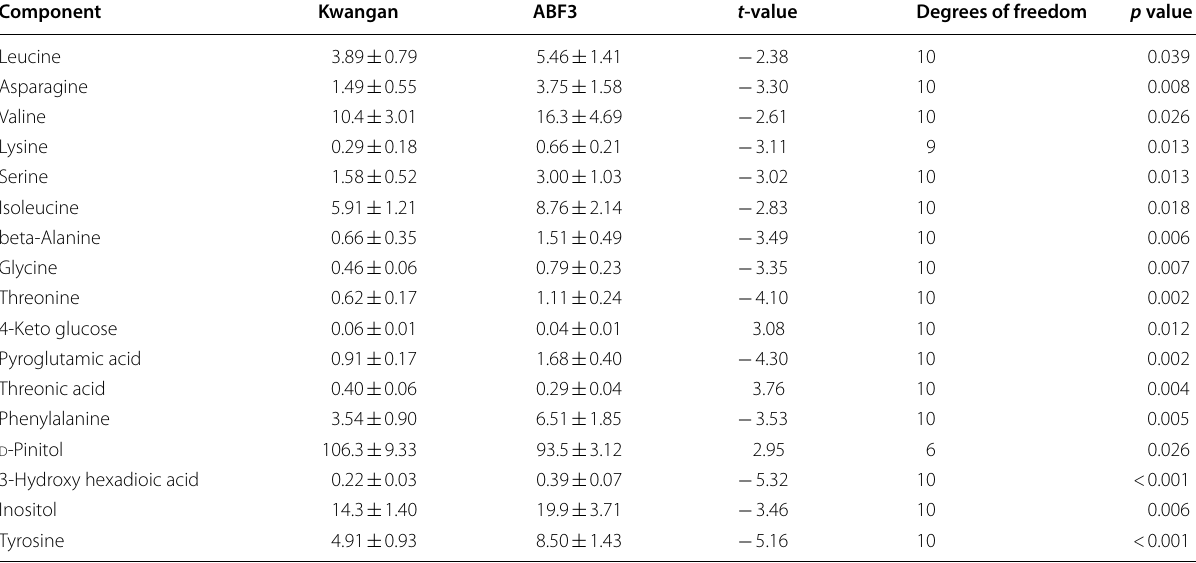
Relative amounts were determined by peak area ratio of analyte to internal standard. Values are means (n t